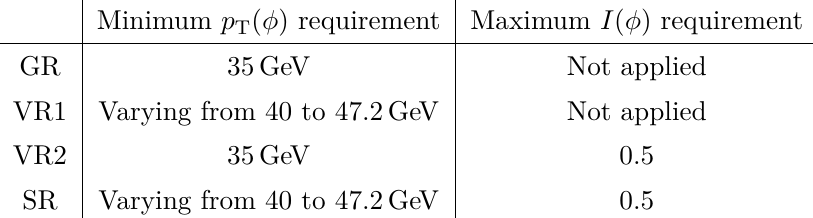
Table 1 . The event selection criteria of the “Signal Region” which are modified to define the “Generation Region” and “Validation